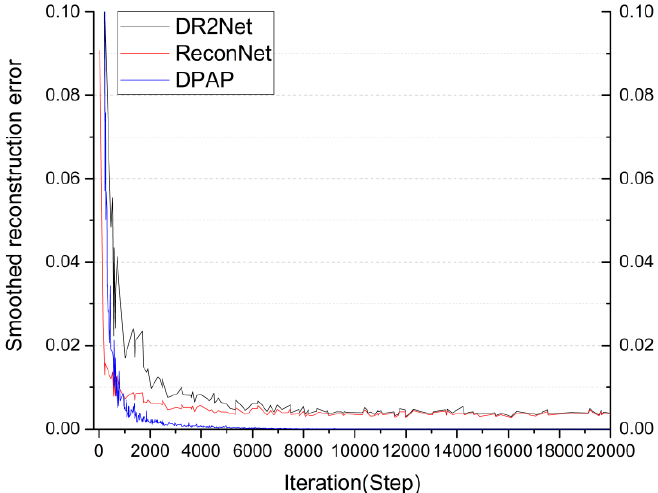
Figure 15. Loss curves of ReconNet, DR2Net and DPAP at a measurement rate of 0.05.